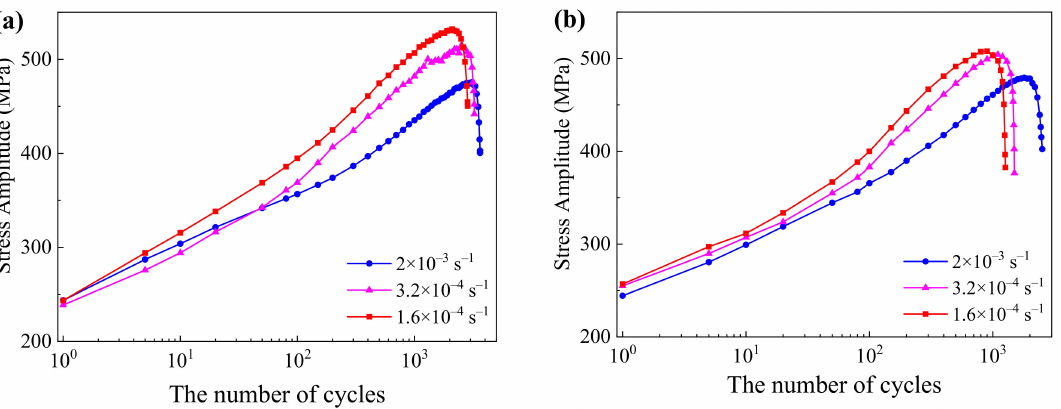
Figure 5. Influence of strain rate on the cyclic stress amplitude response curves at ( a ) 700 ◦ C and